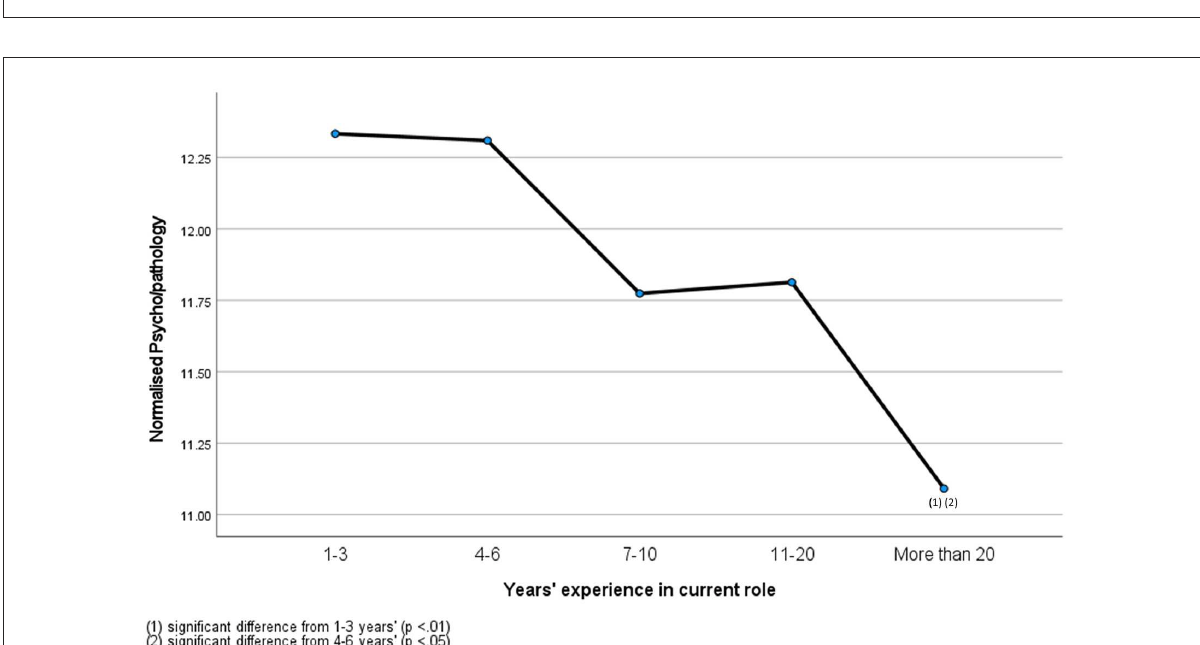
FIGURE2 Normalized psychopathology of veterinary professionals with different years’ experience.